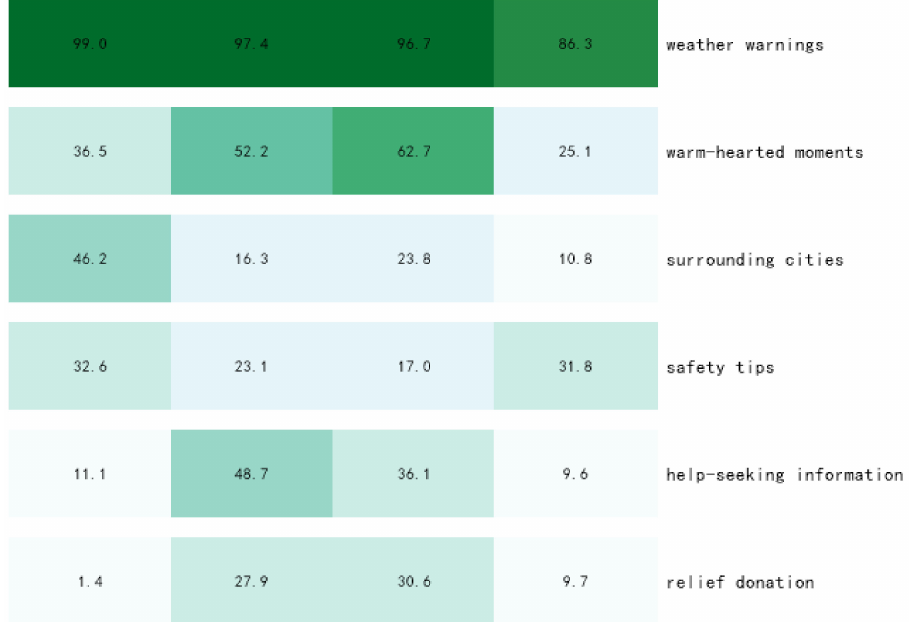
Figure 6. Distribution of thematic heat map of public opinion information dissemination cycle.